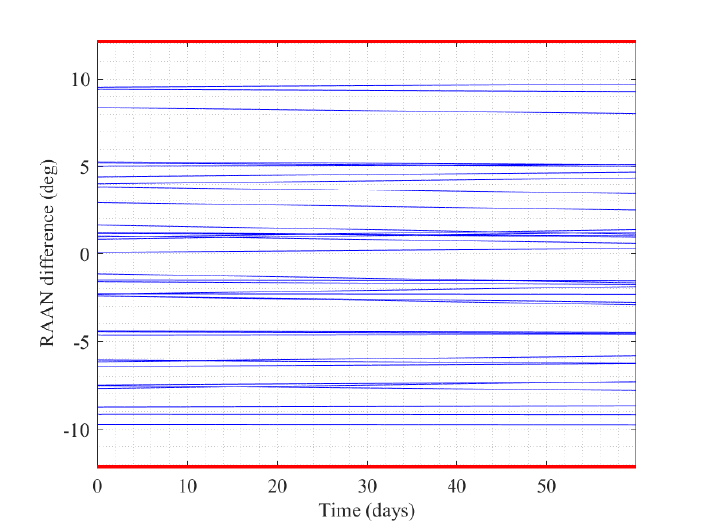
Figure 17. RAAN differences away from the target RAAN under J 2 perturbation. Red lines represent δ Ω min and δ Ω max respectively. Blue lines represent RAAN differences.